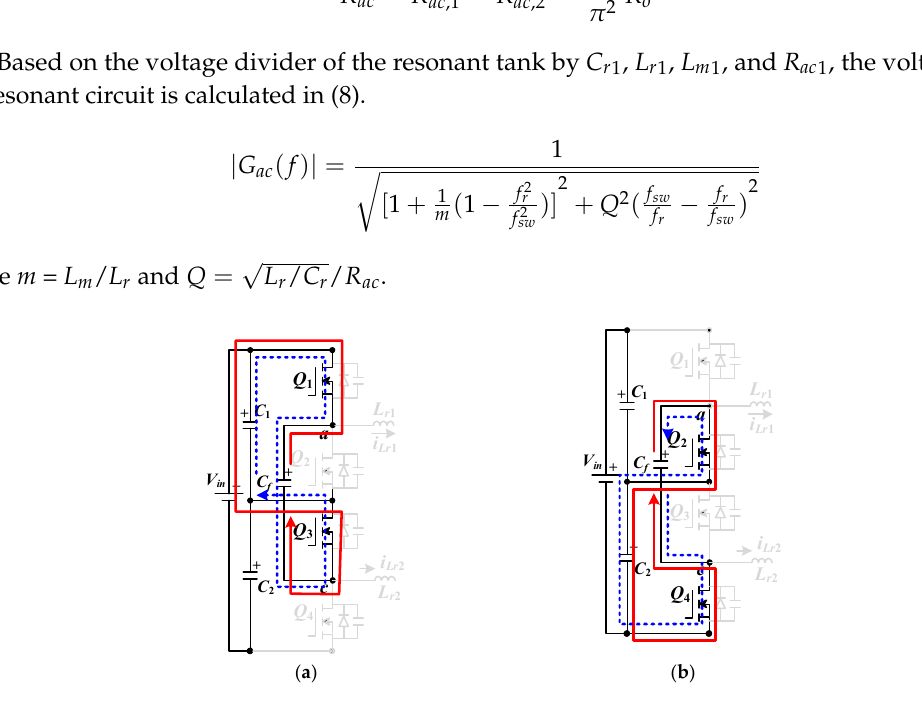
Figure 6. Voltage-balancing by flying capacitor ( a ) Q1 and Q3 on ( b ) Q2 and Q4 on.